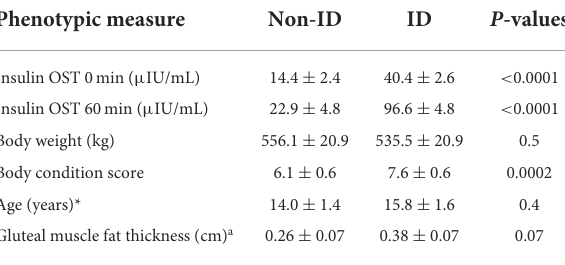
TABLE 1 Phenotypic measures and insulin status of ID and non-ID groups.